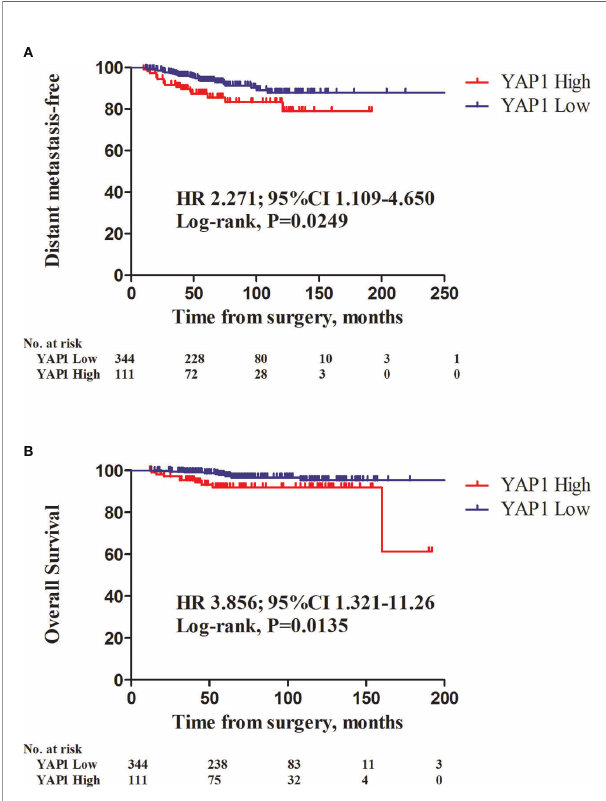
FIGURE 2 | Kaplan-Meier survival curves of distant metastasis-free survival (DMFS) and overall survival (OS) in relation to nuclear YAP1 expression. Patients with high nuclear YAP1 expression exhibited poor DMFS and overall survival (OS) ( A , HR 2.271, 95% CI 1.109 – 4.650, P = 0.0249; B , HR 3.856, 95%CI 1.321 – 11.26; P = 0.0135, log-rank test,